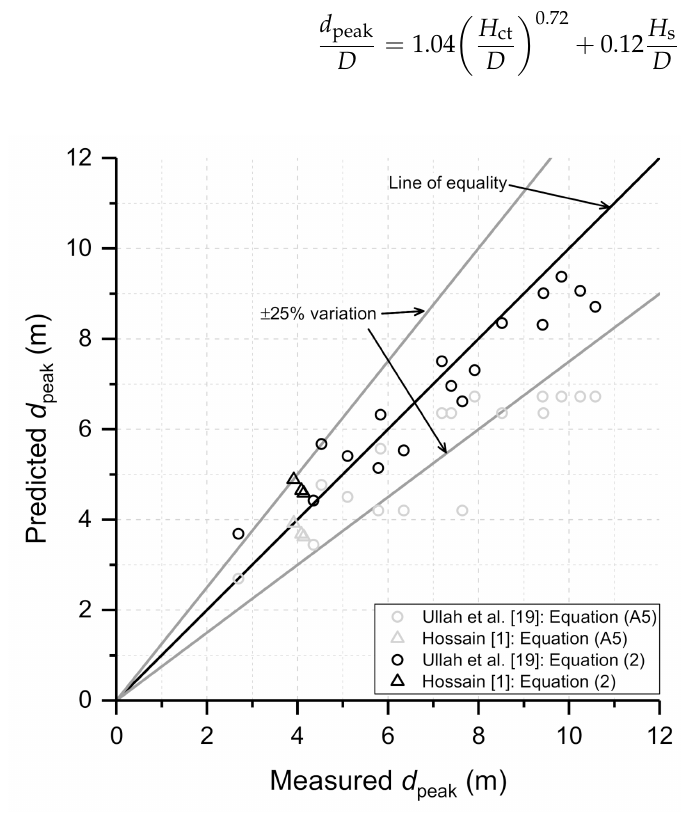
Figure 3. Comparison between measured and predicted depths of peak